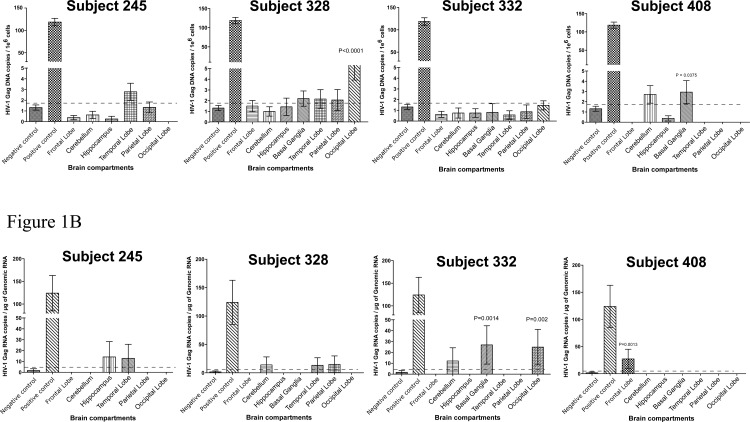
Droplet digital PCR detection of HIV-1 DNA and RNA in brain tissues of viral suppressed individuals.(A) HIV-1 gag DNA copies per million cells in various brain tissues (B) HIV-1 gag RNA copies per million cells in various brain tissues. Basal Ganglia was not available for subject 245. P-value indicate statistically significant from background/negative control. Dash lines indicate cut-off value for ddPCR positivity based on the negative control. Negative control derived from brain tissue of a HIV-1 negative individual. Positive control derived from brain tissue of a HIV-1 positive but ART naïve individual.